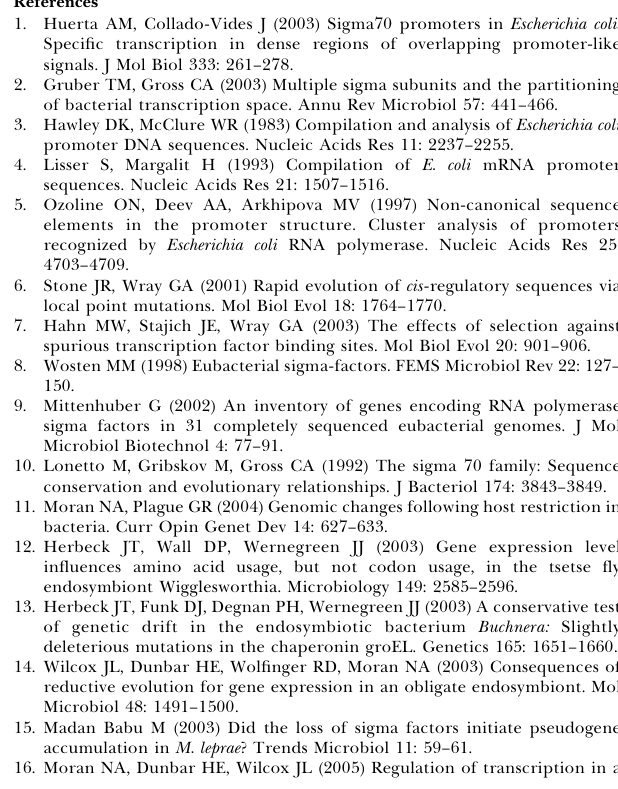
Figure S2. Signal Density in Random Regulatory versus Regulatory Regions for All Analyzed Eubacterial Genomes Table S1. Detailed Examples of M. leprae Pseudogenes with Orthologous Genes in M.